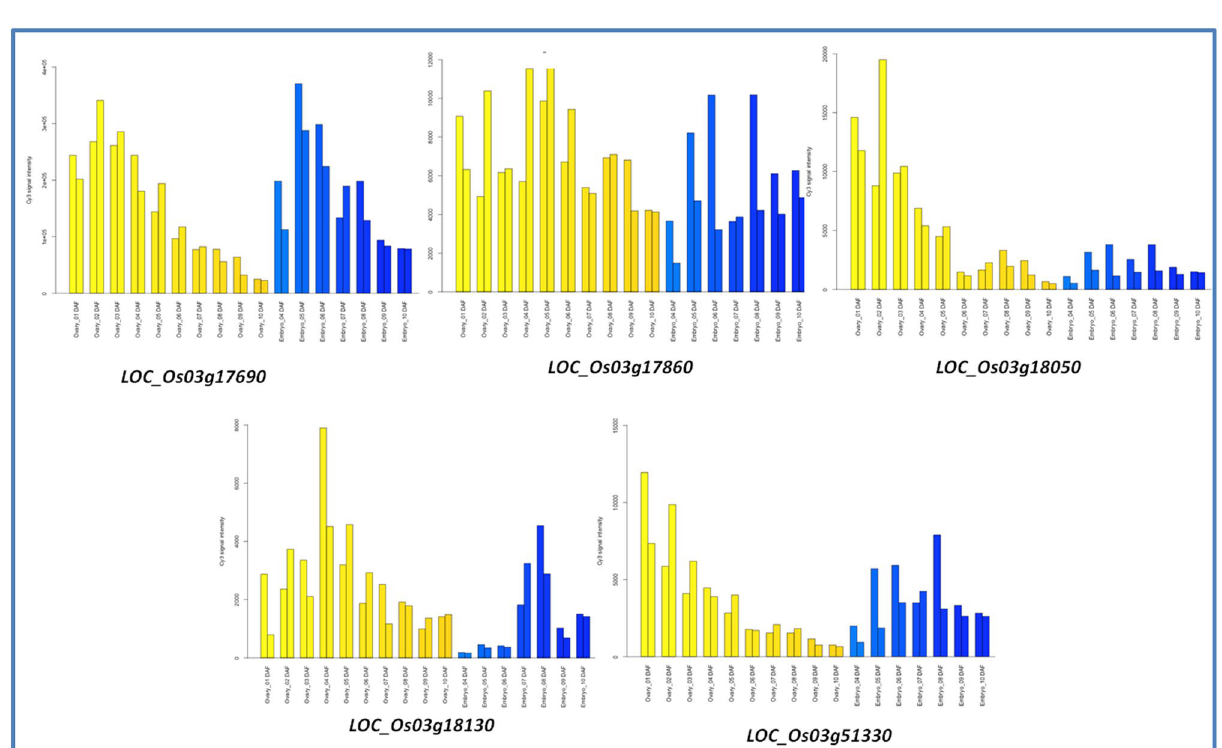
Figure 6. Graphical representation of expression of candidate genes at early grain development stage. The yellow bars taken in two replicates indicate expression of candidate genes in ovary at different days after flowering, whereas the blue bars indicate expression of genes in embryo at different days after flowering, and represented in two